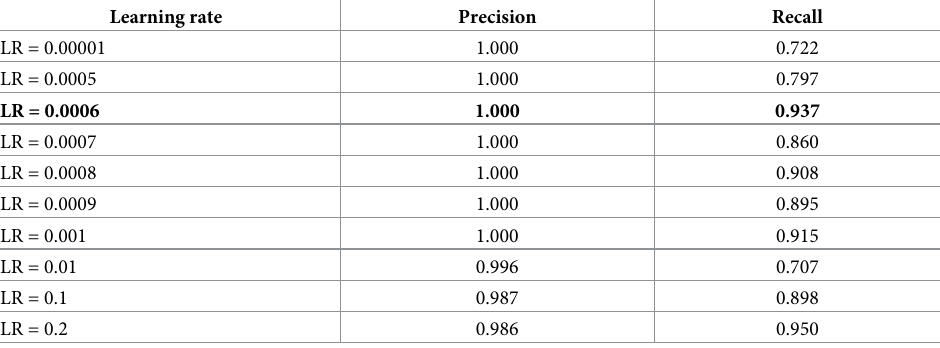
Table 1. Results of variation in learning rate (LR) for ResNet-152. Learning